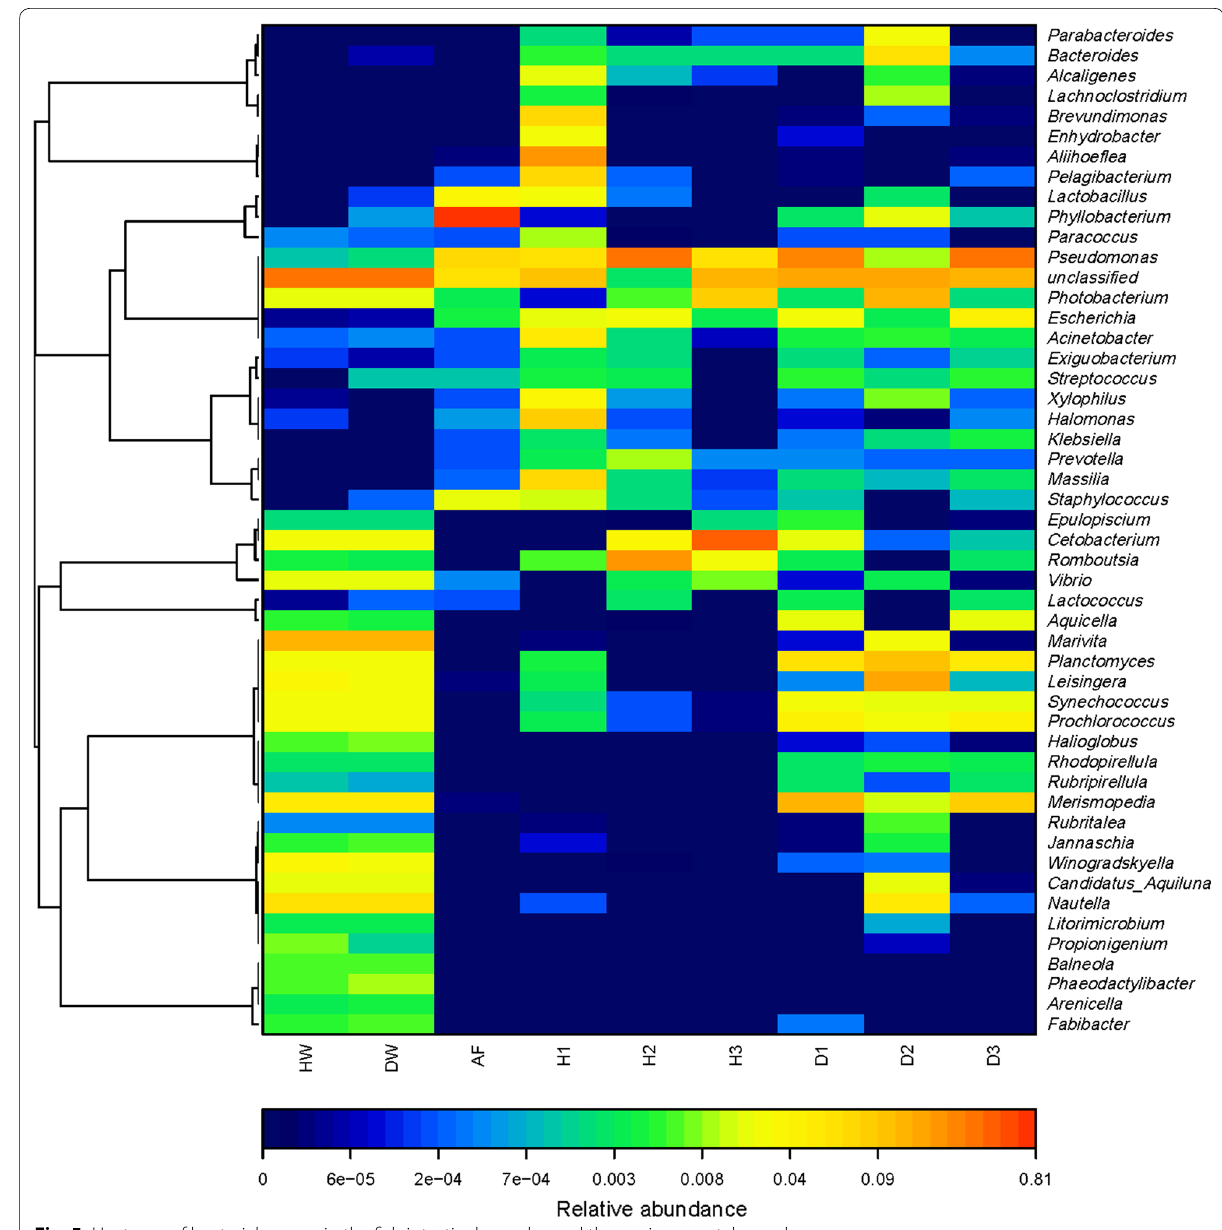
Fig. 5 Heatmap of bacterial genera in the fish intestinal samples and the environmental